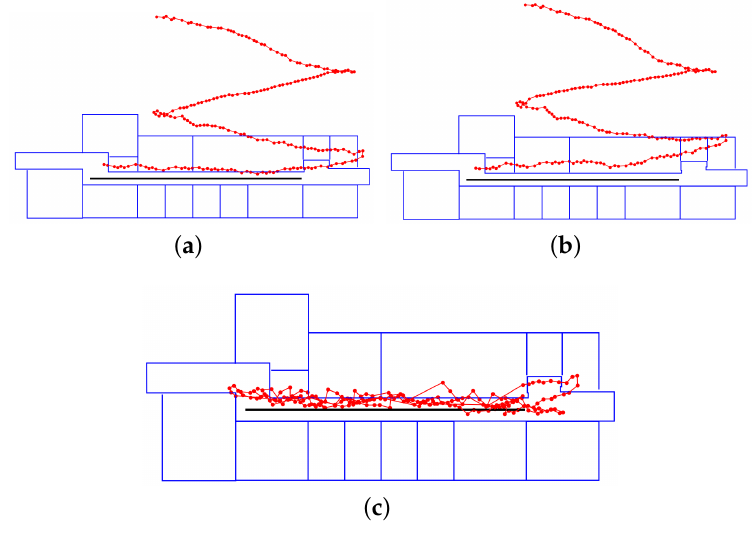
Figure 14. Trajectory of Route 2 when the heading was randomly swayed: ( a ) PDR locations; ( b ) PDR locations after orientation filtering; and ( c ) the path derived from the fusion workflow.